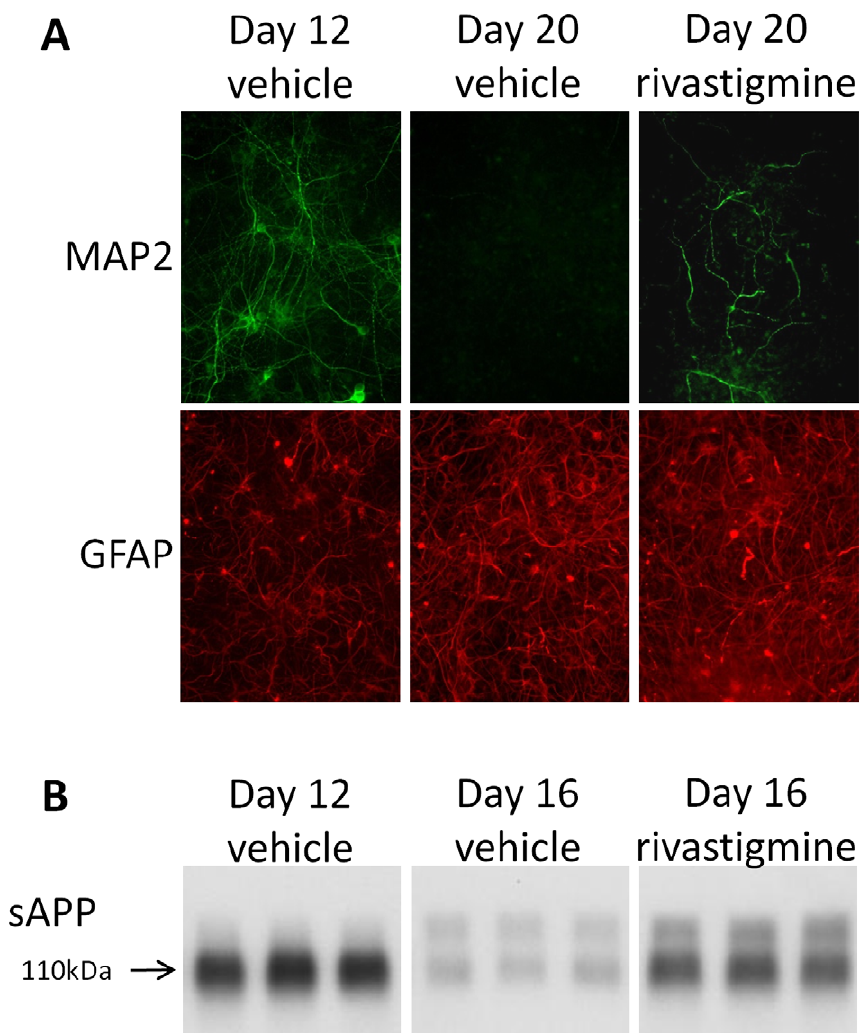
Figure 2. Rivastigmine preserves neuronal morphology and alters sAPP secretion. A : At day 12 or day 20, cells were fixed for immunocytochemistry analysis and probed with anti-MAP2 (green) and anti-GFAP (red) antibodies. Neuronal MAP2 immunoreactivity declines to almost undetectable levels between day 12 and day 20 in untreated cells, whereas neuronal morphology is preserved in rivastigmine treated cultures. Glial GFAP was observed to increase in both treated and untreated cells between day 12 and day 20. These results confirm the degeneration of neurons by day 20. All samples were examined on the same blot with irrelevant samples cropped from the images. B : In a separate experiment, media samples were taken before the onset of neurodegeneration at day 12 and during the degenerating phase of the cell culture at day 16. The lower molecular weight neuronal form of sAPP declined significantly in untreated cells, but was rescued by 10 m M rivastigmine treatment.